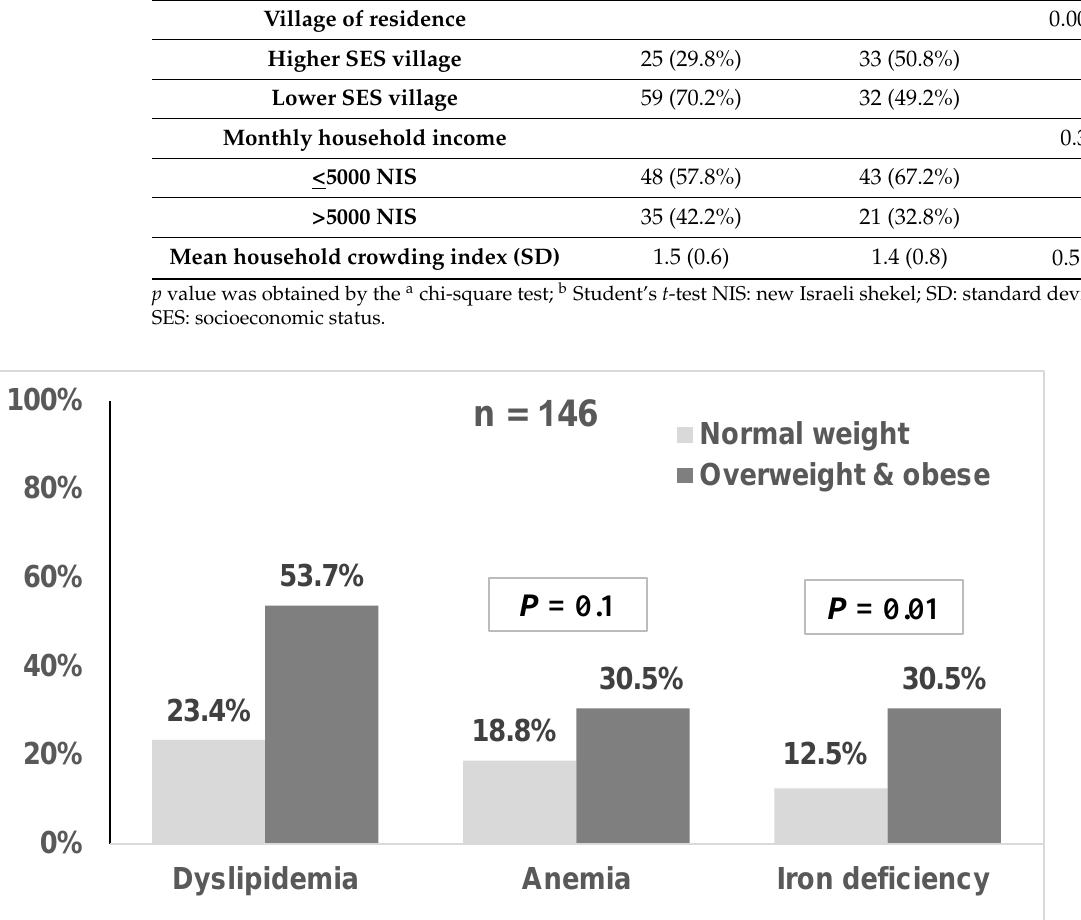
Table 2. Differences in the plasma/serum levels of nutritional and inflammatory markers between participants with normal and those with obesity/overweight .